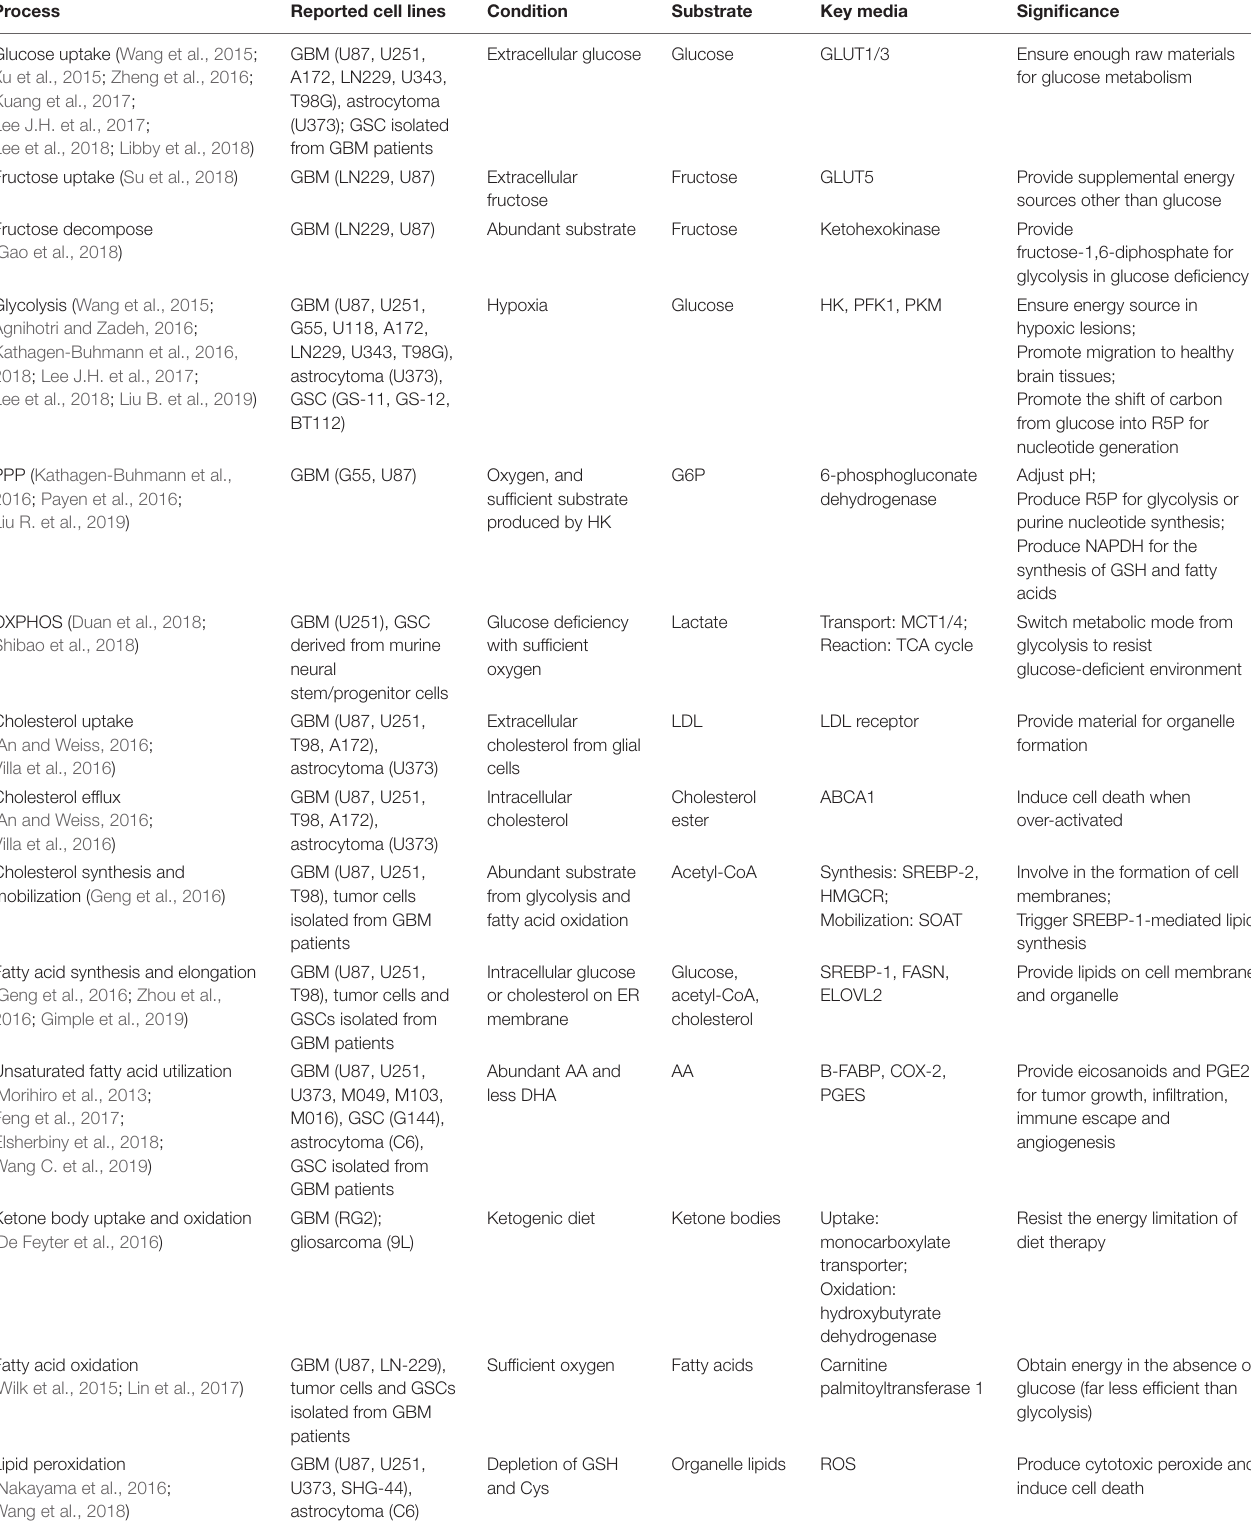
TABLE 1 | Metabolism processes of glioma cells and